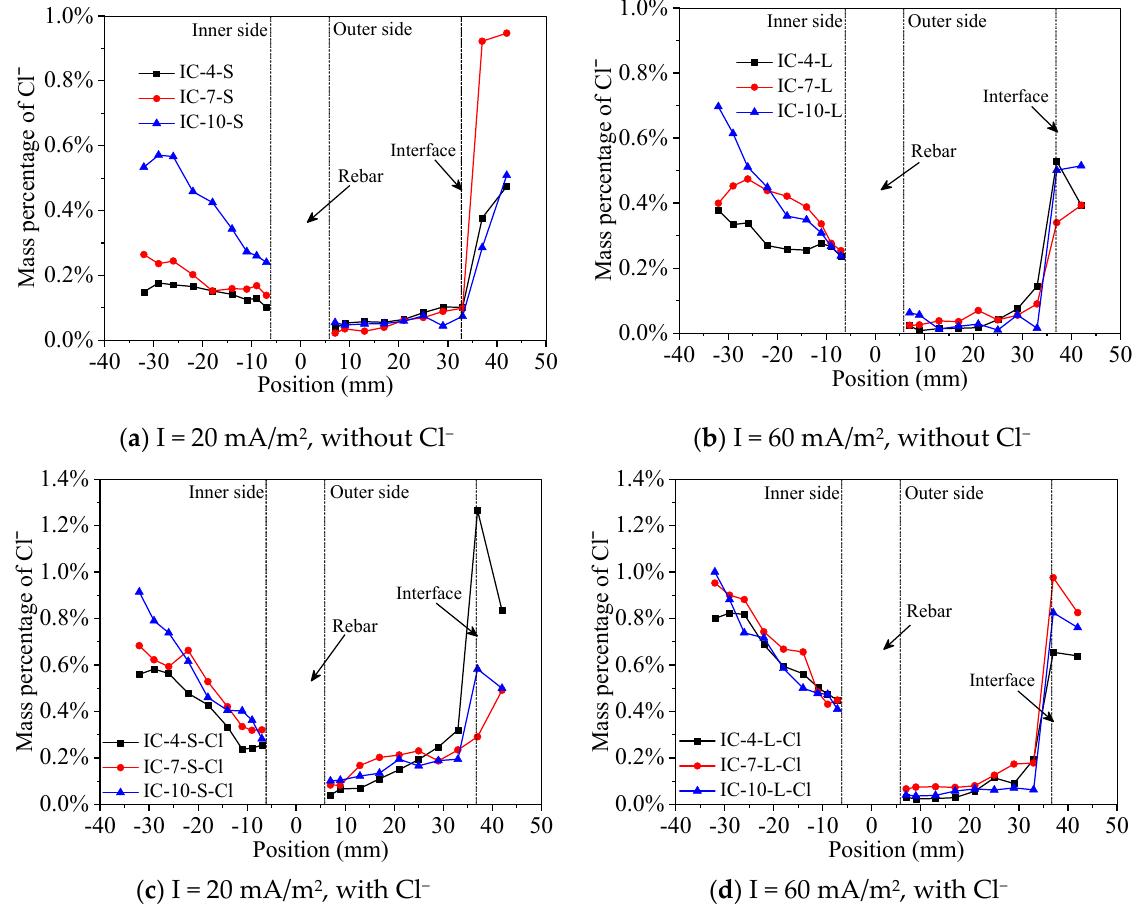
Figure 11. Influence of different conduction times and salt addition on the distribution of Cl − content on both sides of rebars.